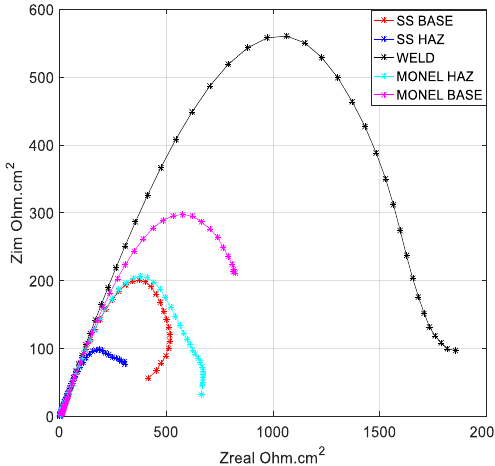
Figure 12. Nyquist plot for CT specimen.